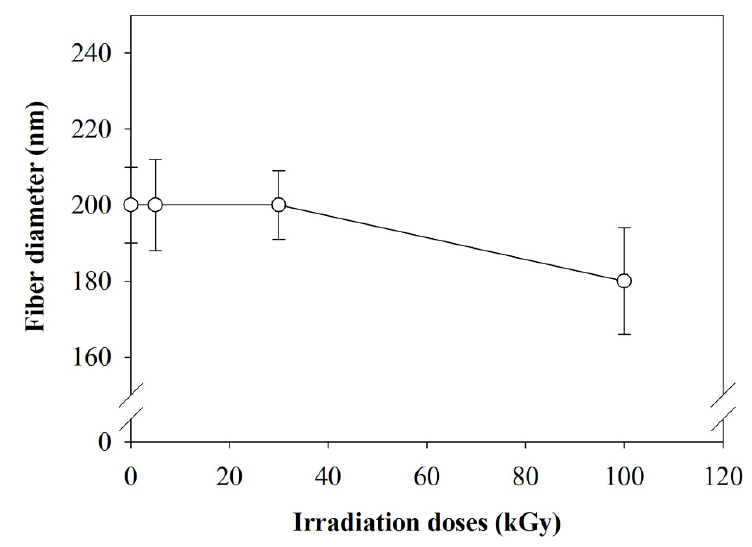
Figure 2. An average of fiber diameter with increase of irradiation dose.